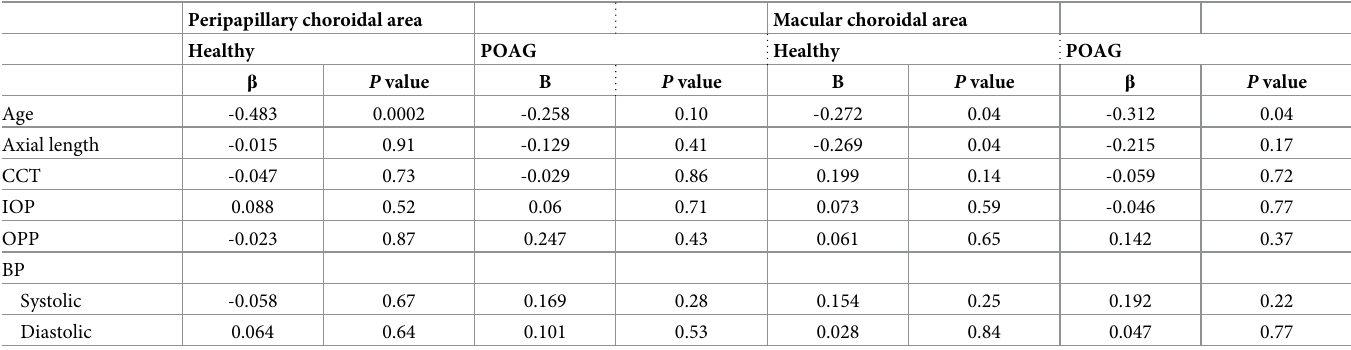
Table 3. Univariate regression analysis of choroidal area with associated factors.